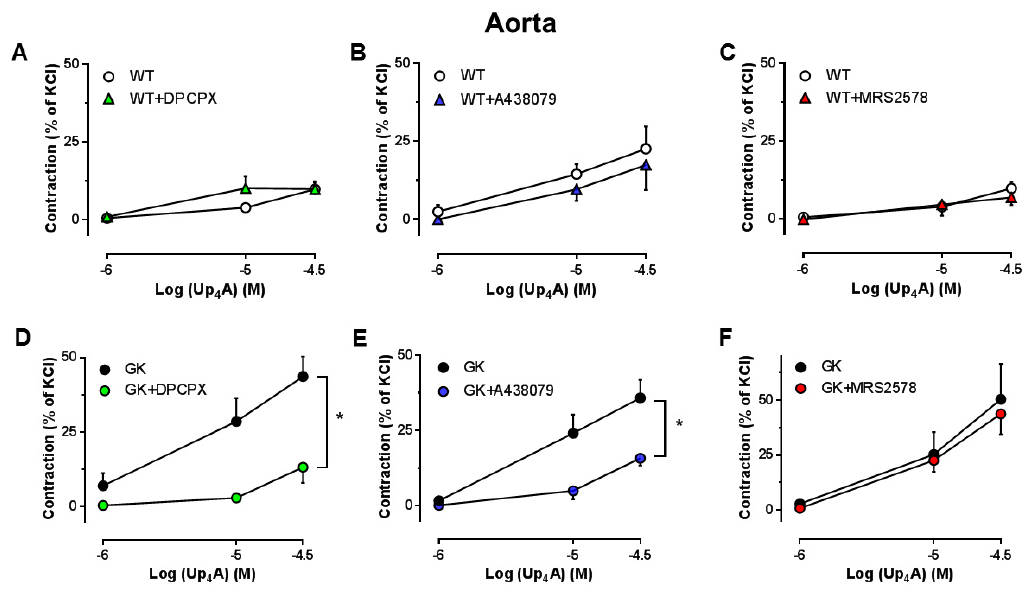
Figure 7. Effects of specific antagonism for A1R, P2X 7 R, and P2Y 6 R on vasoconstrictor response to Up 4 A in aortas from WT and GK rats. Concentration response curves for Up 4 A in aortas in the absence and presence of the A1R antagonist (DPCPX, 10 − 8 M) ( A , WT n = 3; D, GK n = 4), the P2X 7 R antagonist (A438079, 10 − 5 M) ( B , WT n = 6; E, GK n = 6), and the selective P2Y 6 R antagonist (MRS2578, 10 − 5 M) ( C , WT n = 3; F, GK n = 4). Data are presented as mean ± SEM as percentage contraction of KCl. * p < 0.05 calculated with two-way ANOVA.